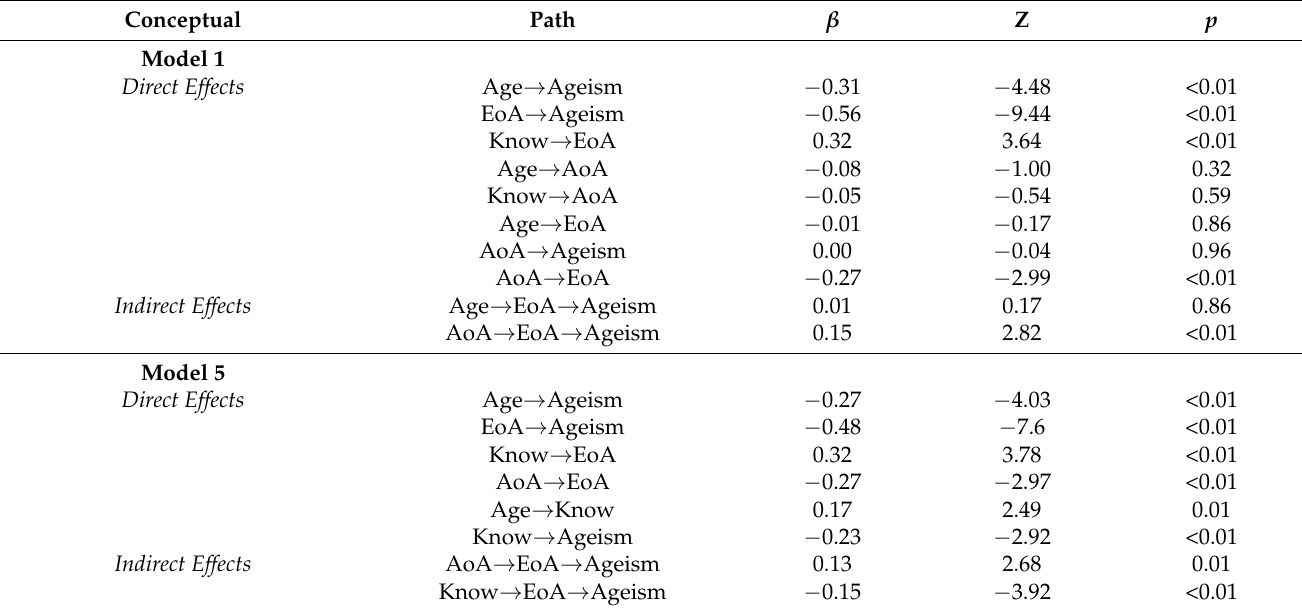
Table 5. Standardized coefficients, Z statistics, and p -values of direct and indirect paths from the conceptual and final models.